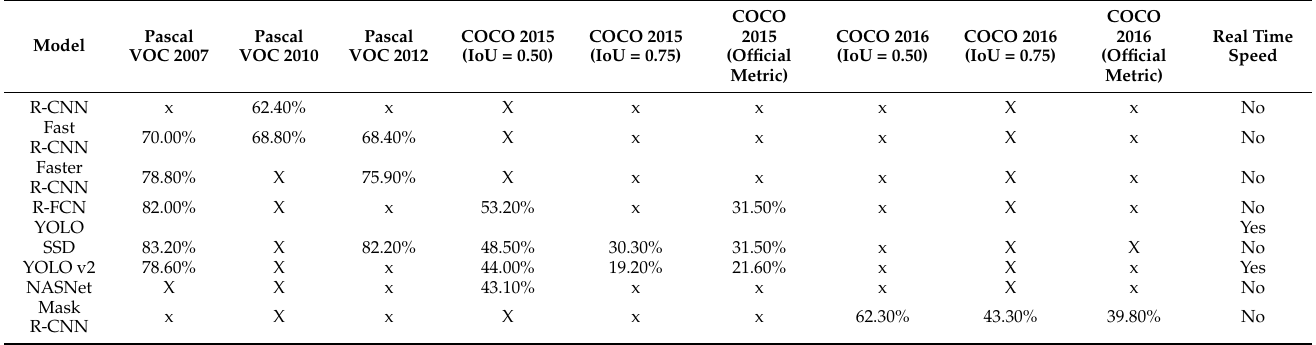
Table 1. mAP scores on the 2007, 2010, 2012 PASCAL VOC dataset and 2015, 2016 COCO datasets [46].